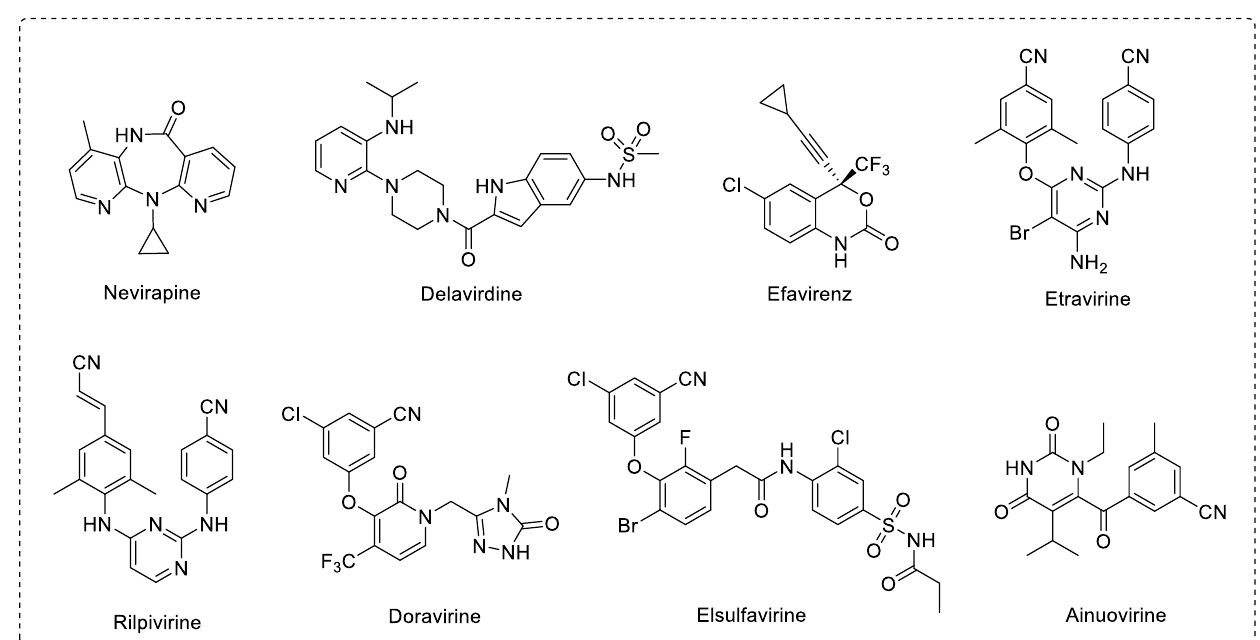
Figure 1. Chemical structures of approved HIV-1 NNRTI drugs.